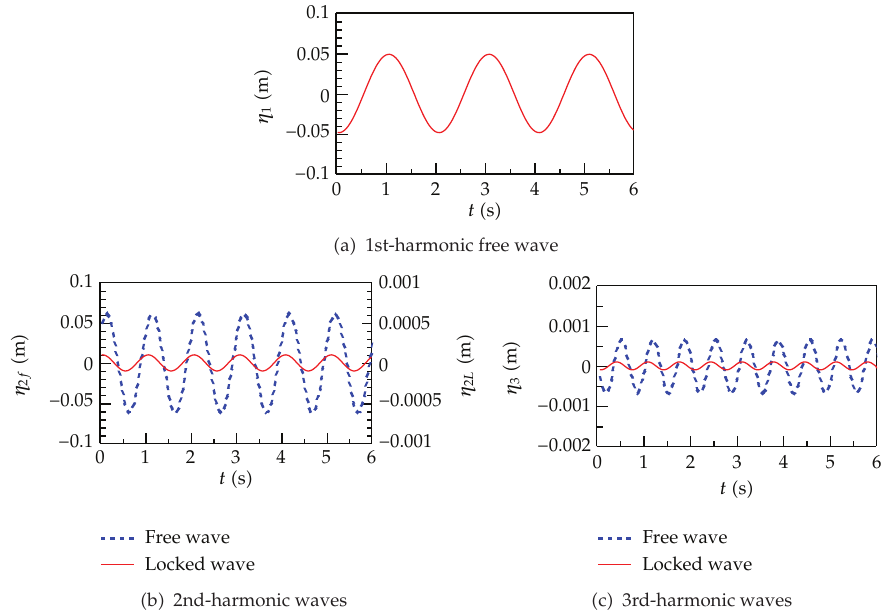
Figure 6: Time histories of various order harmonic waves for weakly nonlinear condition (cid:2) A (cid:9) 0 . 05m, h (cid:9) 0 . 8m (cid:3)